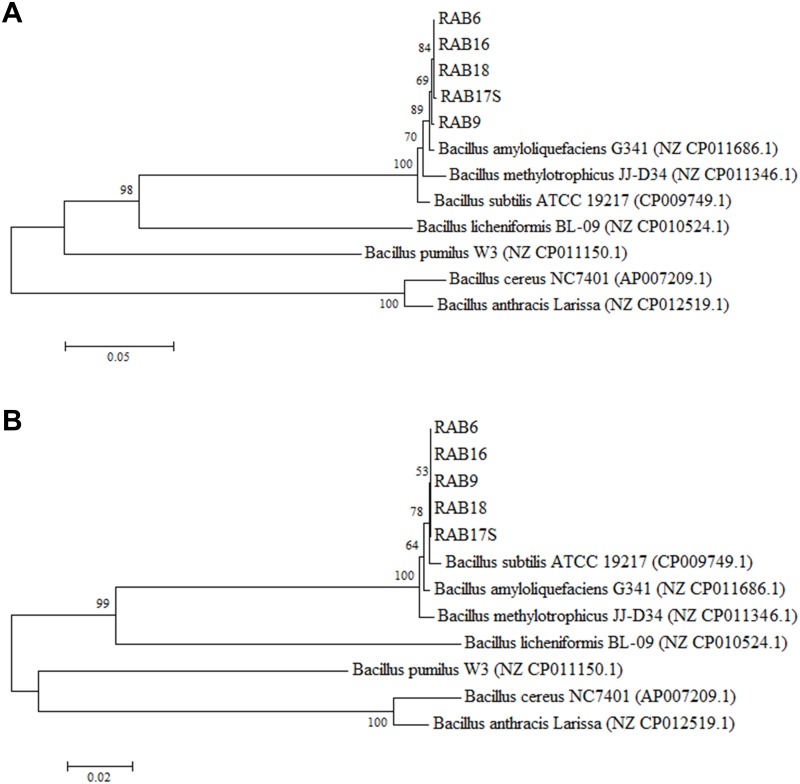
Phylogenetic tree based on gyrB (A) and recA (B) sequences of the five rice-associated bacteria (RABs) and other Bacillus species from GenBank nucleotide database.GenBank accession numbers for the sequences obtained from the database are given in parentheses. The tree was generated using neighbor-joining method, and genetic distances were calculated using the Kimura 2-parameter method using MEGA5 [76]. Numbers at nodes indicate percentage of occurrence in 1000 bootstrapping. The bar at the bottom of the tree indicates the scale for genetic distances. Burkholderia glumae 336gr-1 was used as an out-group control.